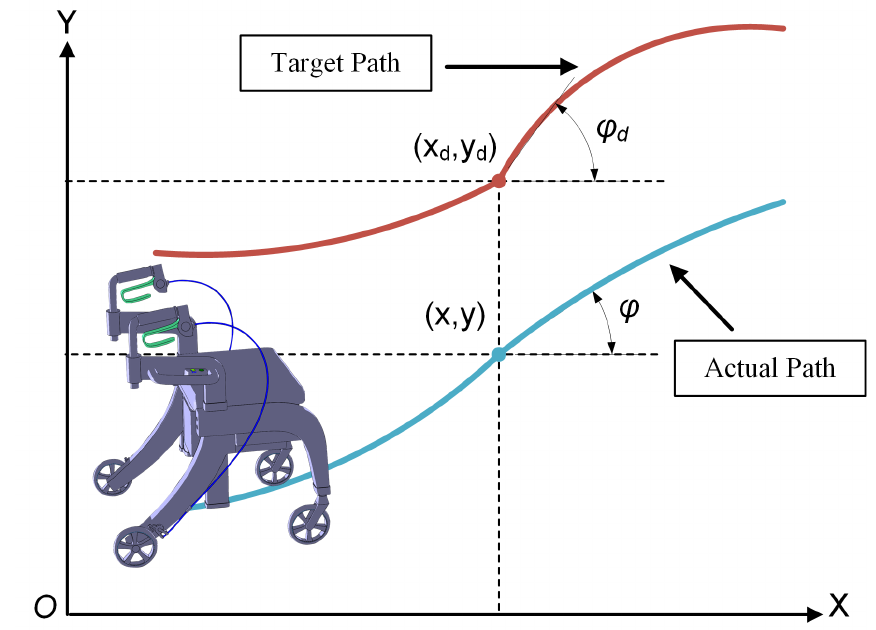
Figure 8. Tracking error